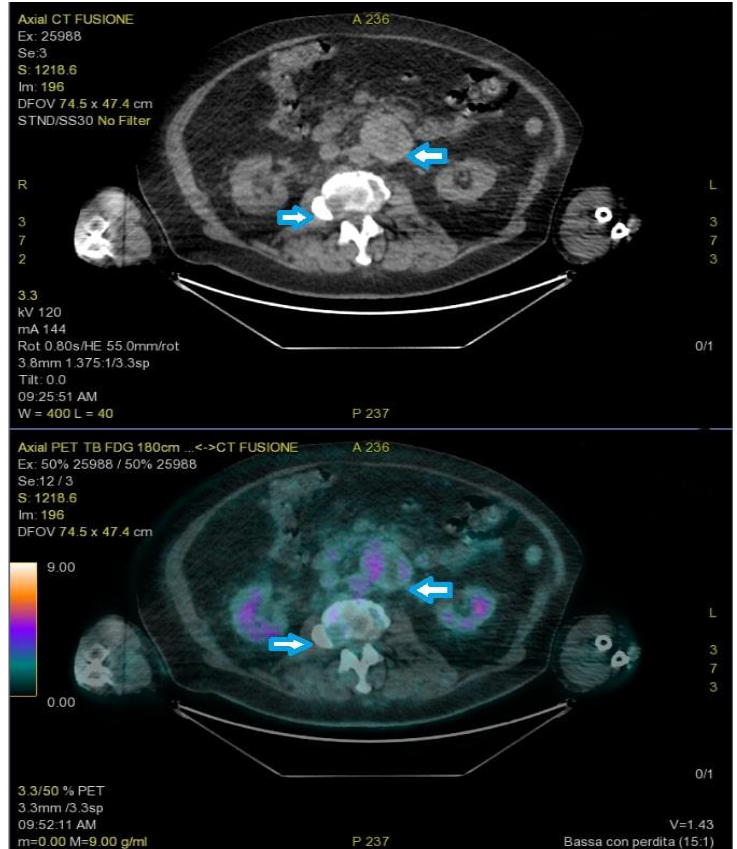
Figure 3. PET-FDG showed a round-shaped enhanced mass in the left para-aortic region and multiple areas of elevated SUV in the lumbar spine (arrows).